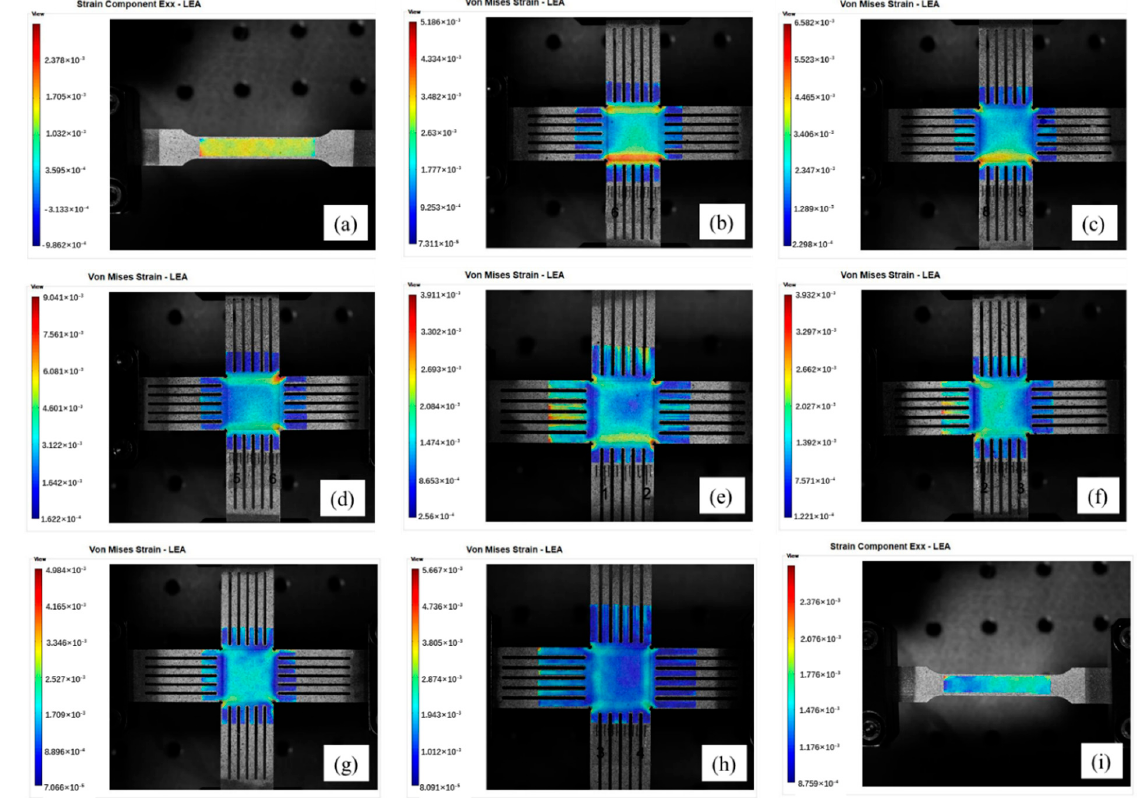
Figure 4. Strain contour plots at various load ratios (100 MPa): ( a ) 0:4, ( b ) 1:4, ( c ) 2:4, ( d ) 3:4, ( e ) 4:4, ( f ) 4:3, ( g ) 4:2, ( h ) 4:1, ( i ) 4:0.